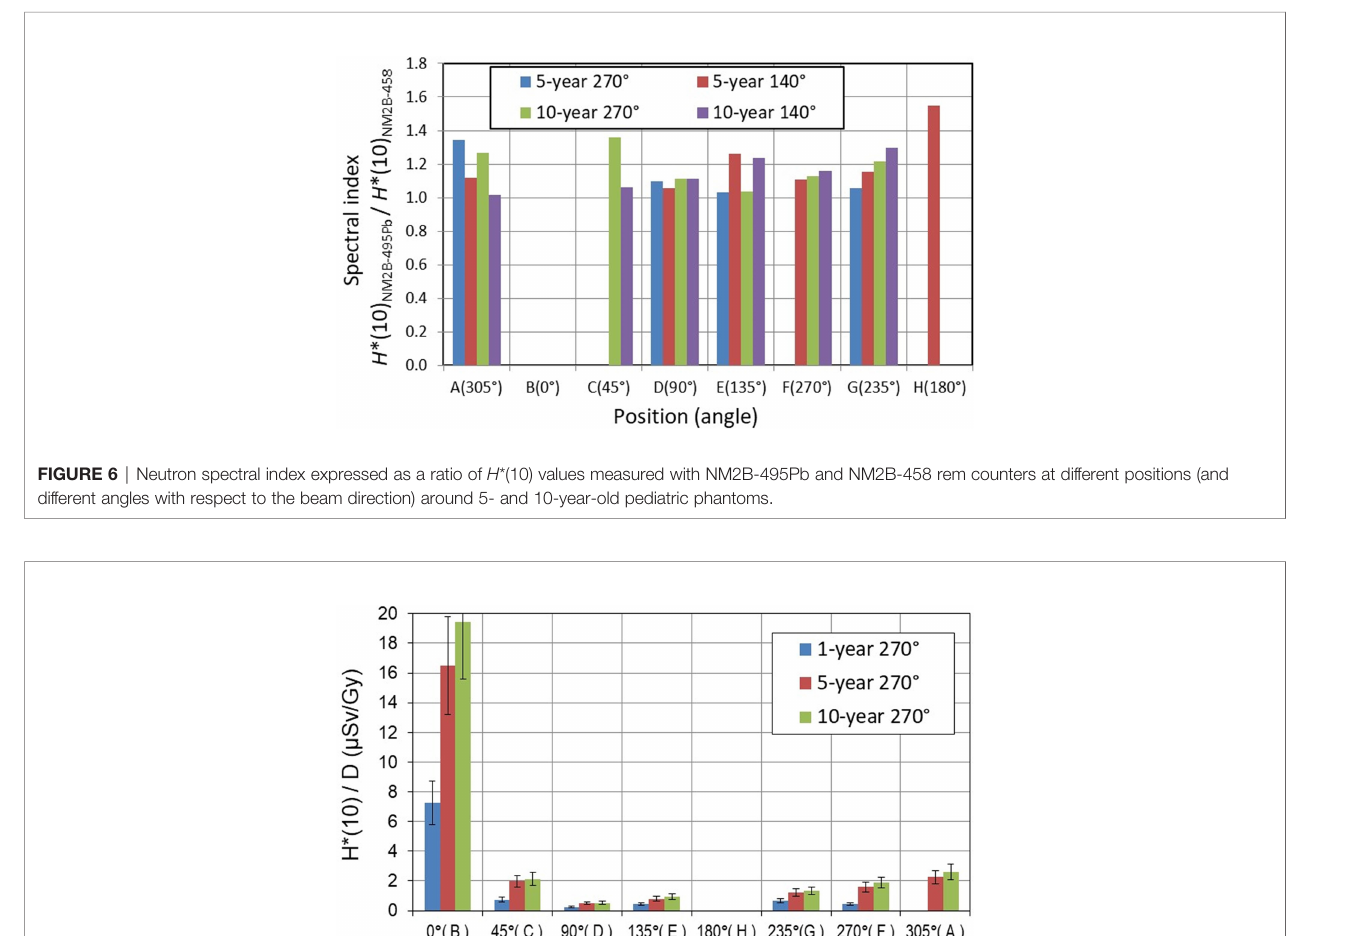
Frontiers in Oncology |